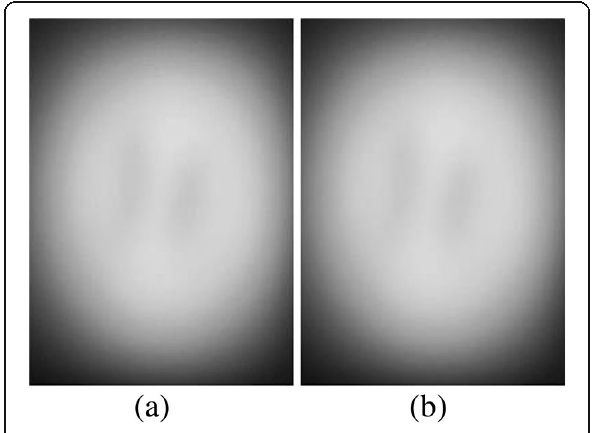
Fig. 5 The comparison of original image and the image of wavelet transform denoising. ( a ) is the original image grayscale image, and ( b ) is the wavelet denoising